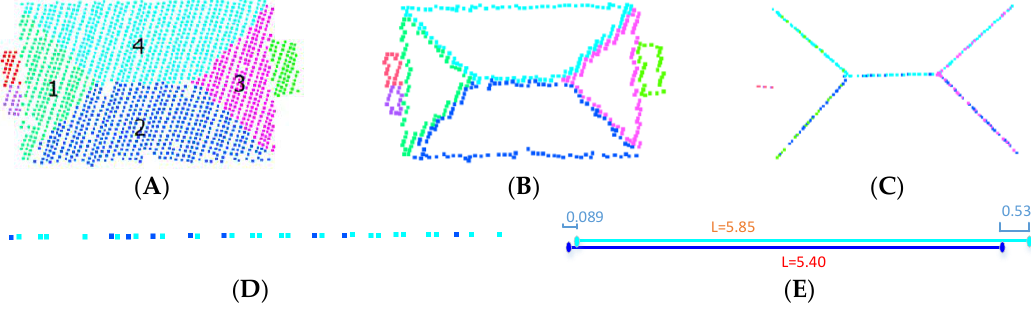
Figure 13. ( A ) Segmentation results; ( B ) boundaries and ( C – E ) the process of the determination of topological relations among components extracted from point cloud.